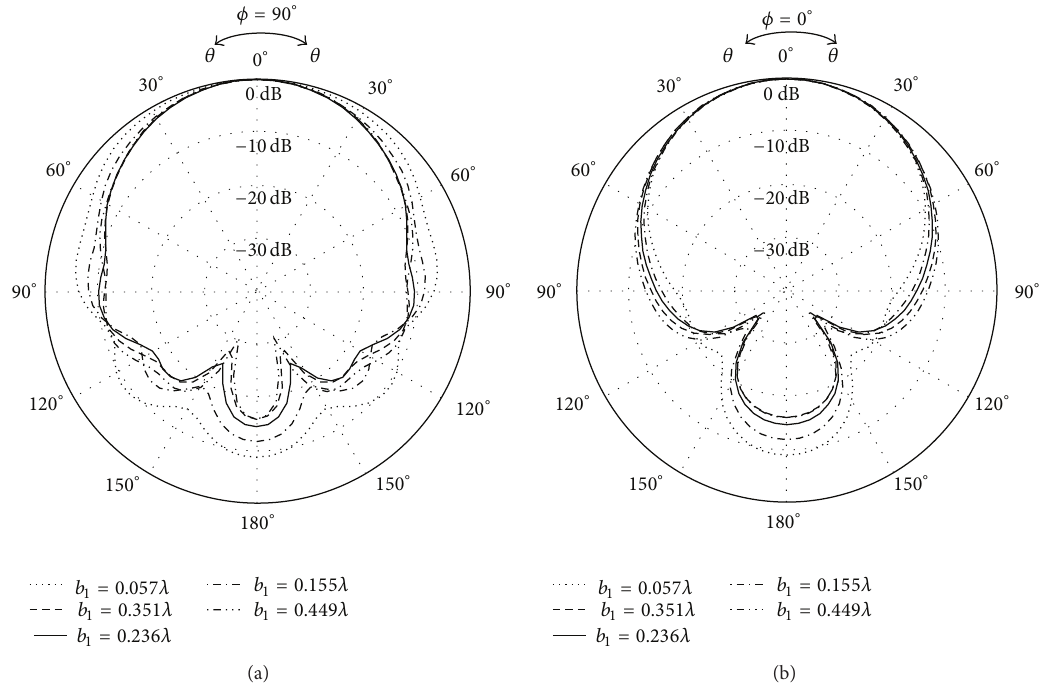
Figure 13: Simulated radiation patterns for various parasitic coupling aperture heights ( 𝑏 1 ) at the lower frequency of 2.412 GHz in (a) the 𝐸 -plane and (b) the 𝐻 -plane.